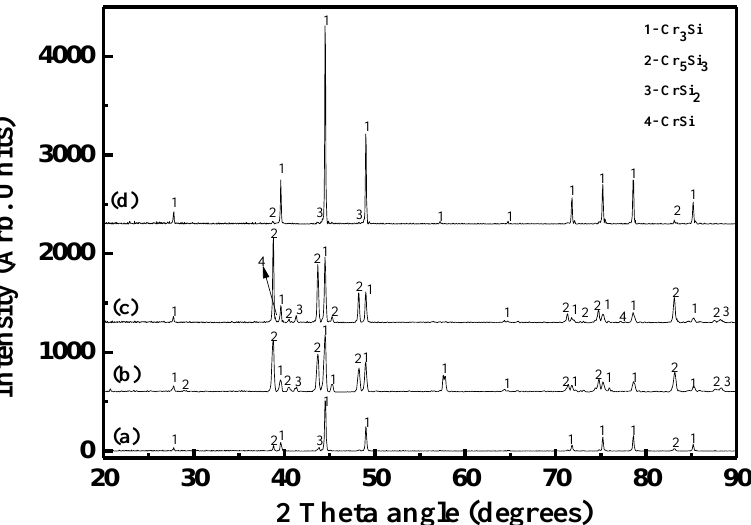
Figure 7. XRD pattern of the chromized sample obtained by use of 40 wt.% Cr in the pack mixture at 1000 °C for ( a ) 120 min; ( b ) 60 min; ( c ) 30 min; ( d ) 15 min. The peaks were indexed by use of PDF #75-2250 (Cr 3 Si), #51-1357 (Cr 5 Si 3 ), #35-0781 (CrSi 2 ) and #51-1356 (CrSi) [34].